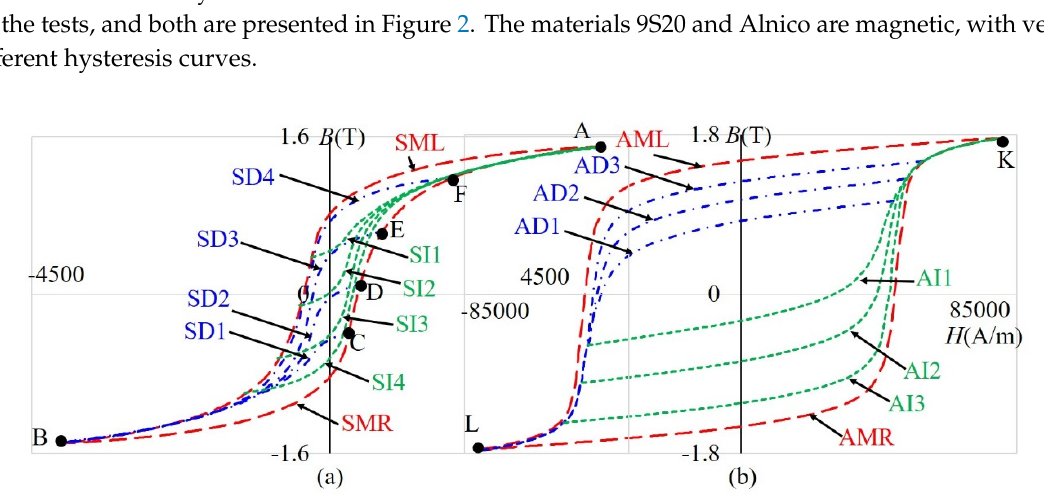
Figure 2. Measured hysteresis of materials: ( a ) 9S20; ( b ) Alnico.